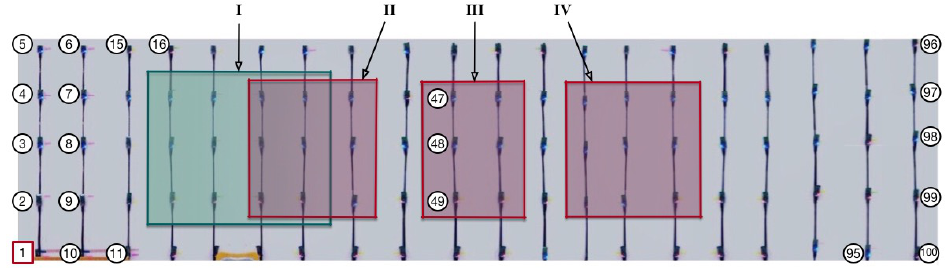
Figure 7. Deployment of the testbed involving 100 TelosB nodes. Node 1 is the sink node that collects the data generated by the other